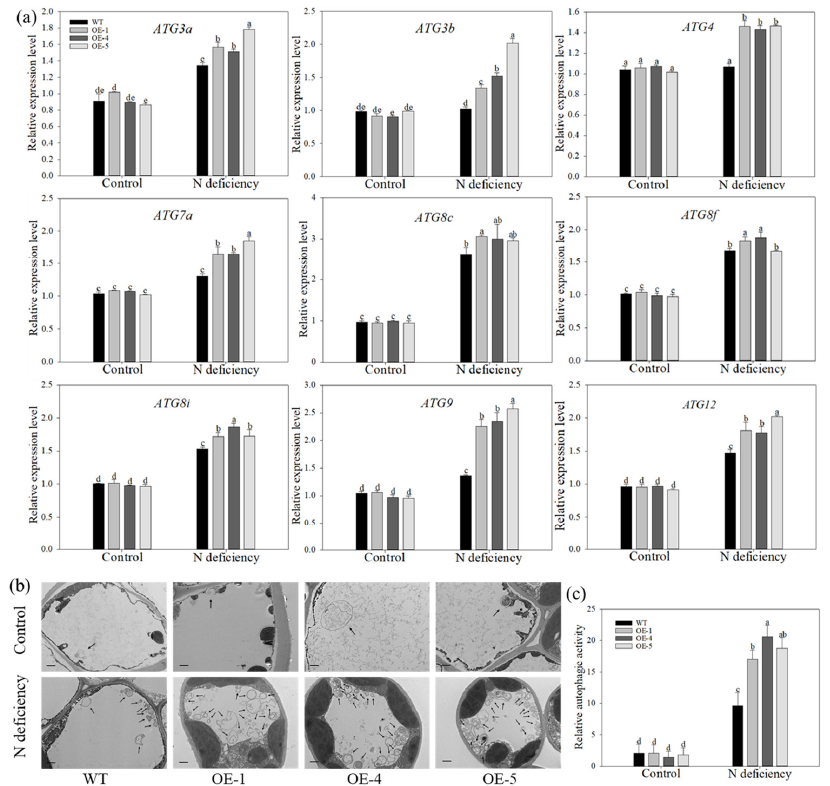
Figure 8. Expression of other MdATGs and formation of autophagosomes in apple following nitrogen deficiency treatment. ( a ) Changes in expression of other MdATGs in WT and MdATG10 -OE plants following nitrogen deficiency treatment. ( b ) Representative TEM images of autophagic structures in mesophyll cells of WT and MdATG10 -OE plants. Autophagic bodies are indicated by arrows. Bars: 1 μm. ( c ) Relative autophagic activity normalized to the activity of WT or MdATG10 -OE plants shown in panel ( b ). More than 10 cells were used to quantify structures. Data are the means of six replicates with SE. Different letters indicate significant differences between treatments, according to one-way ANOVA followed by Tukey’s multiple range test ( p < 0.05).